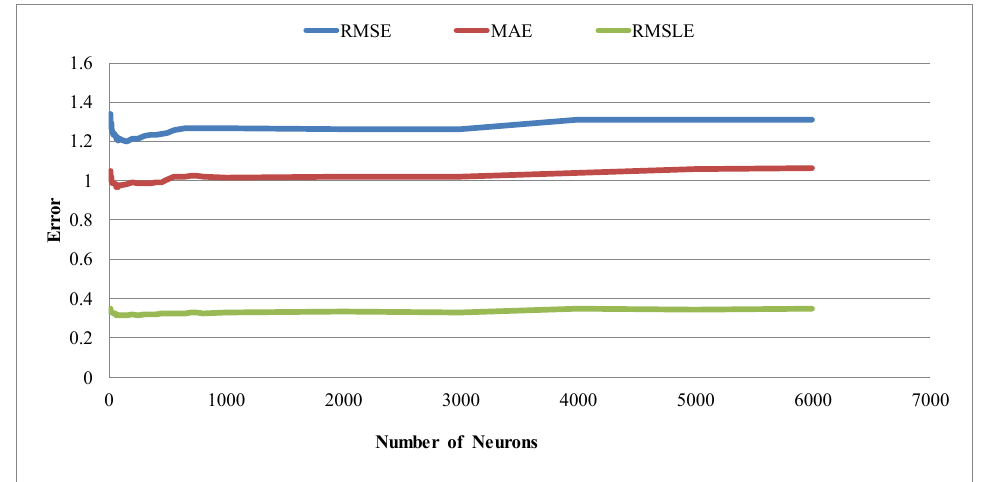
Figure 8. Table showing the number of neurons against error metrics (RMSE, MAE, and RMSLE) for one hidden layer in the validation group. The three metrics are average values. Table 5. Table showing the number of neurons of the lowest three error values for three hidden layers.